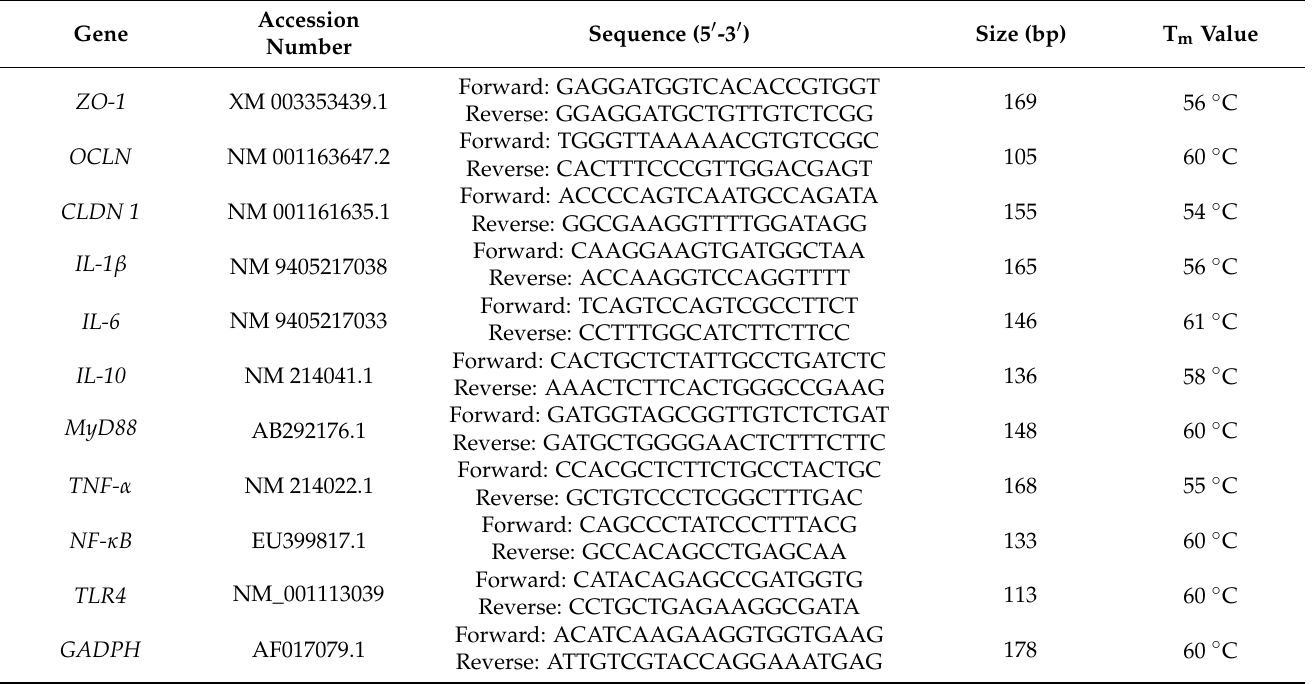
Table 2. Primers for real-time PCR